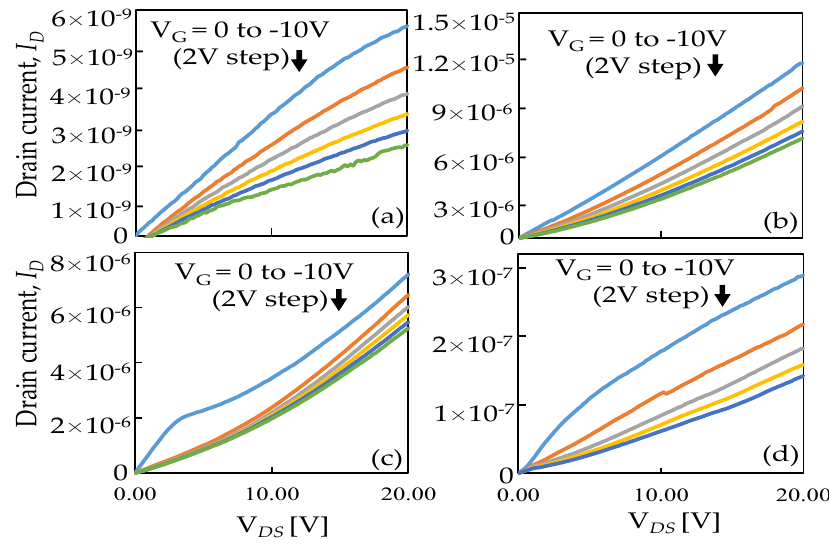
Figure 7. I D –V D characteristics of MESFETs consisting of channels prepared from ( a ) as-prepared ZnO, ( b ) ZnO:Ga-open air, ( c ) ZnO:Ga-N 2 , and ( d ) ZnO:Ga-O 2 .